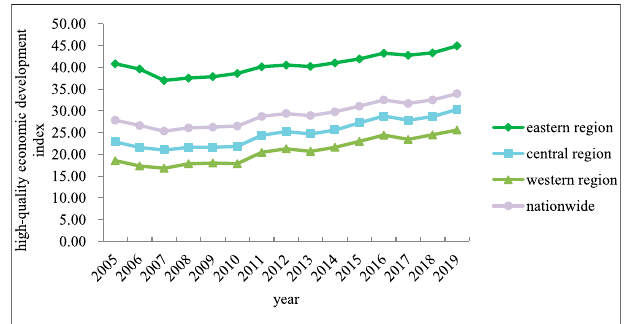
FIGURE 1 | High-quality development trend of China ’ s economy from 2005 to